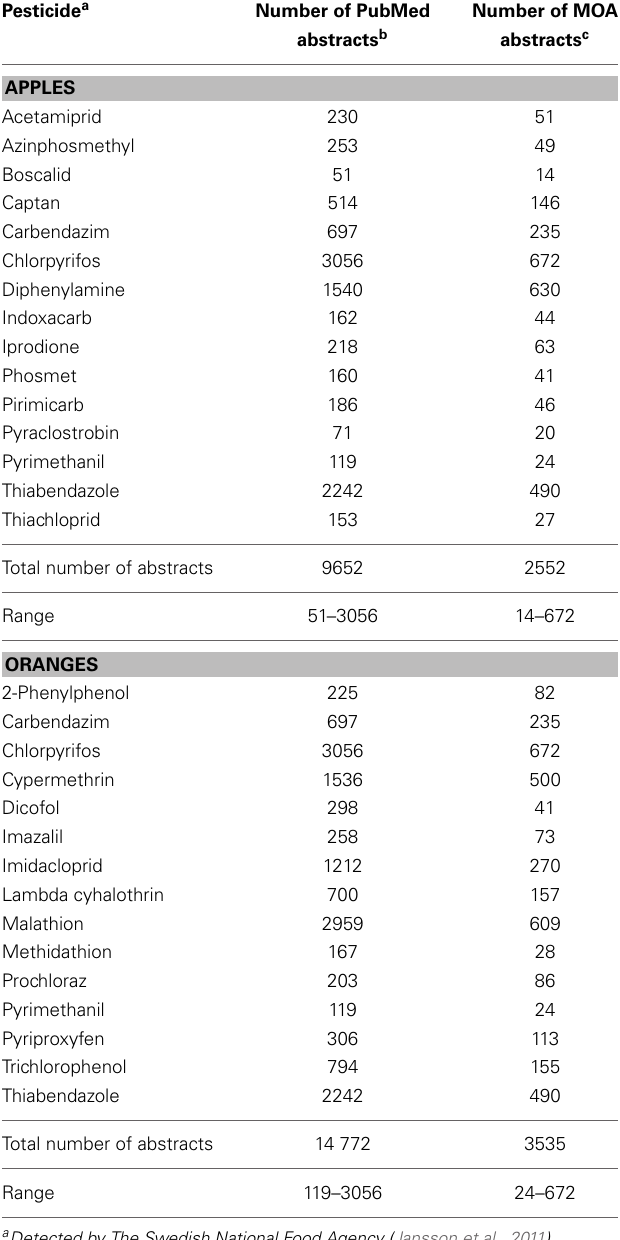
Table 1 | Literature data on the 26 most frequently detected pesticides in apples and in oranges on the Swedish